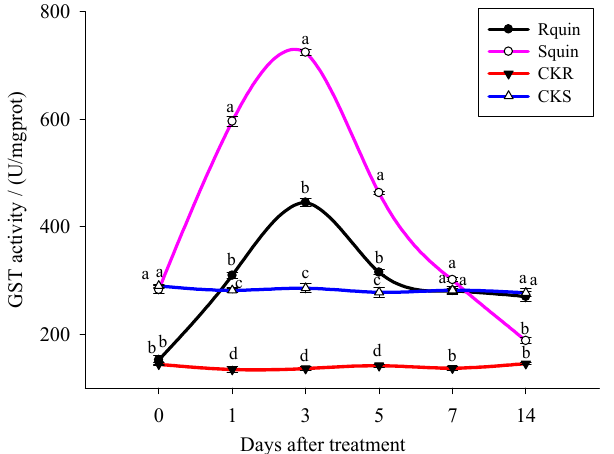
Figure 4. The photosynthetic parameters of quinclorac-resistant (Rquin) and -sensitive (Squin) E. crus-galli with quinclorac treatment. ( a ) Net photosynthetic rate ( Pn ); ( b ) transpiration rate ( Tr ); ( c ) intercellular CO 2 concentration ( Ci ); and ( d ) stomatal conductance ( Gs ). * represents a statistically significant difference ( p < 0.05), and ** represents a statistically significant difference ( p < 0.01).